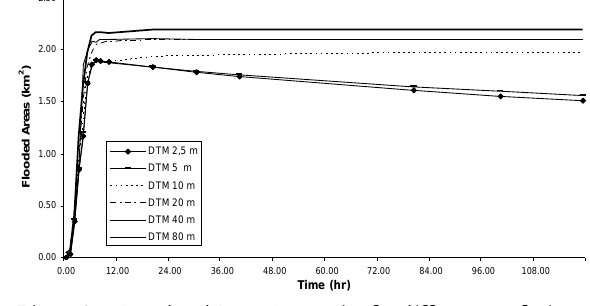
Figure 8. Inundated Areas Dynamics for different resolution of automatically generated DTMs